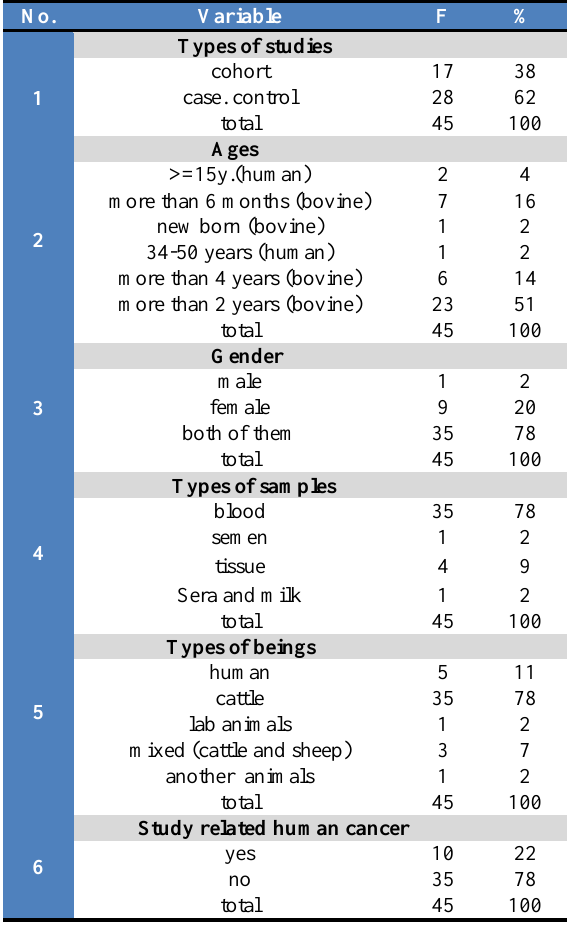
Table, 3: Frequency and percentage of studies according, the